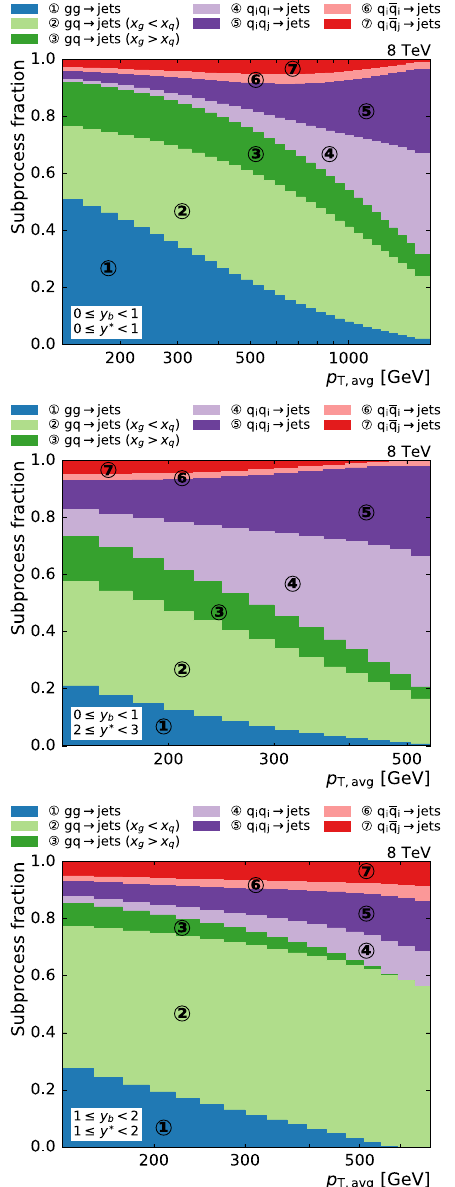
Fig. 2 Relative contributions of all subprocesses to the total cross sec- tion at NLO as a function of p T , avg in the various y ∗ and y b bins. The subprocess contributions are grouped intoseven categories according to